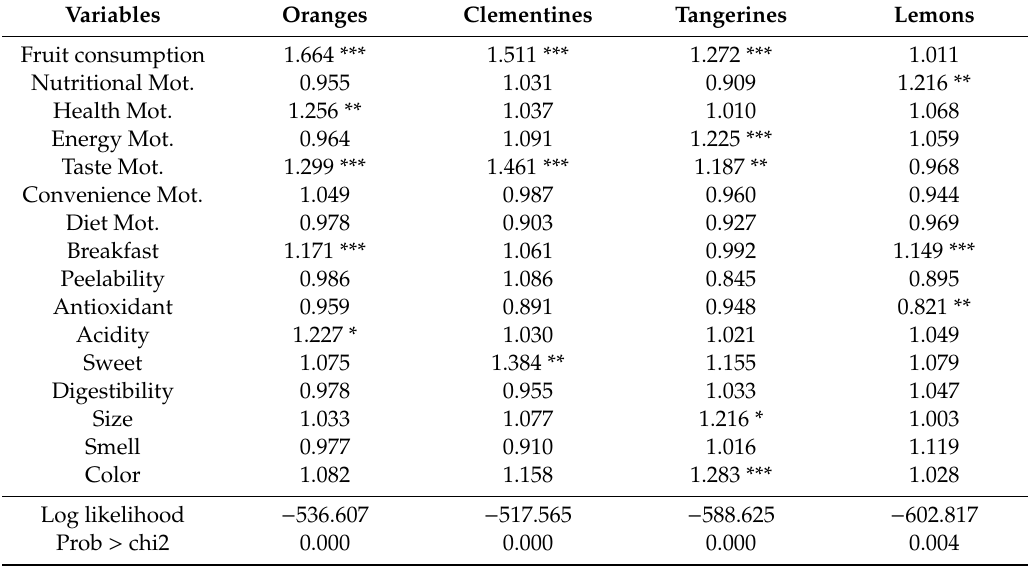
Table 3. Odd ratios of the ordered logistic